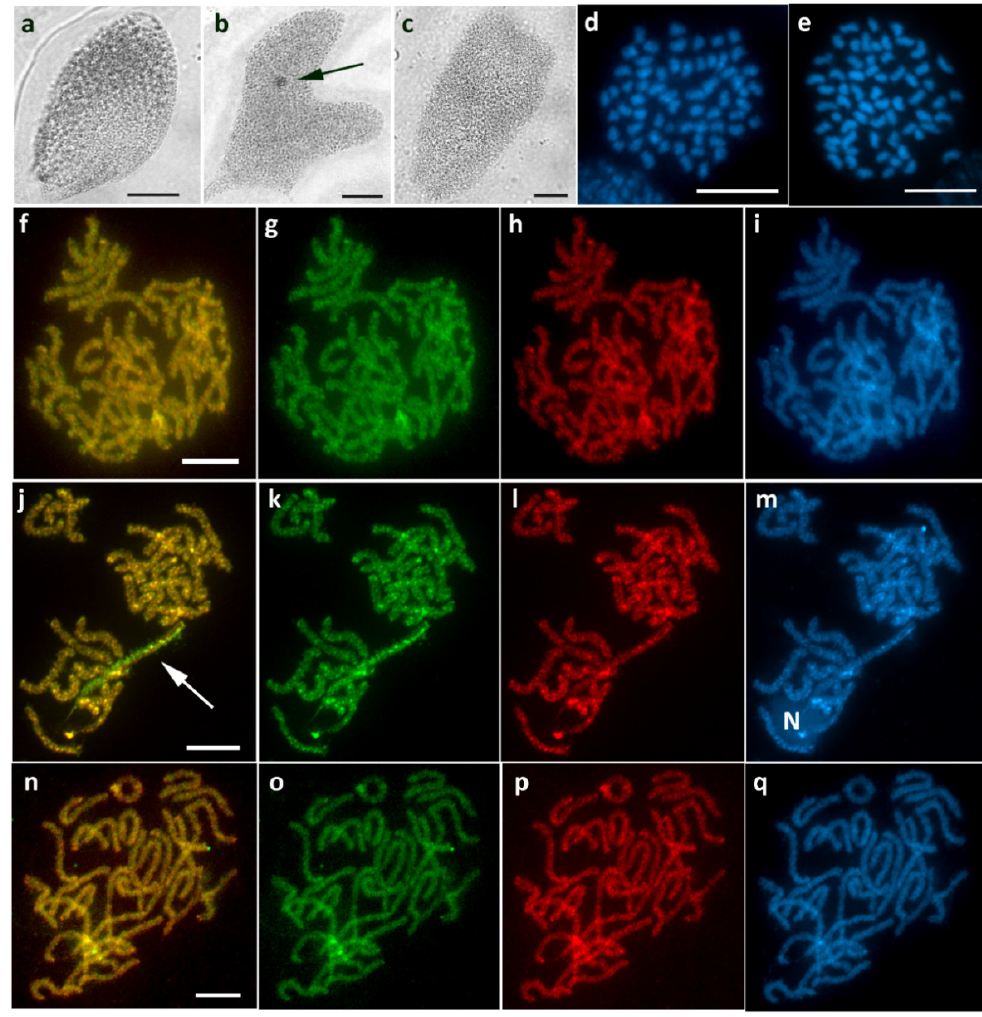
Figure 9. WZ sex chromosomes with variable W in Pseudopanthera macularia . ( a – c ) Orcein-stained polyploid nuclei showing the absence of sex chromatin in females from the first brood ( a ), a small sex chromatin body in females from another brood ( b ), and no sex chromatin in males ( c ). ( d , e ) Mitotic metaphase chromosomes stained with DAPI showing 2 n = 62 in both females ( d ) and males ( e ). ( f – m ) CGH on female pachytene chromosomes failed to identify the WZ bivalent, suggesting the presence of an undifferentiated W chromosome in the first brood ( f – i ), whereas, in two other broods, the W chromosome was strongly labeled with the female genomic probe (( j – m ), arrow); note nu- cleolus (N). ( n – q ) CGH on male pachytene chromosomes without any differentiated chromosome. Panels ( f , j , n )—merged pictures of both probes; ( g , k , o )—female genomic probe (green); ( h , l , p )—male genomic probe (red); ( i , m , q )—DAPI staining (light blue). Bar = 10 µ